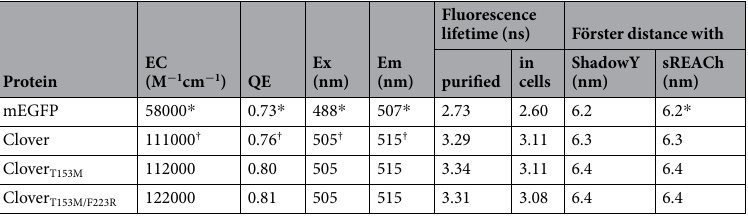
Table 2. Characteristics of Clover mutants. EC: extinction coefficient, QE: quantum efficiency, Ex: excitation maximum, E m : emission maximum. * ,† Values obtained from previously published data 8, 13 , respectively. For the calculation of Förster distance, random interfluorophore orientation were assumed 30 . ND: not